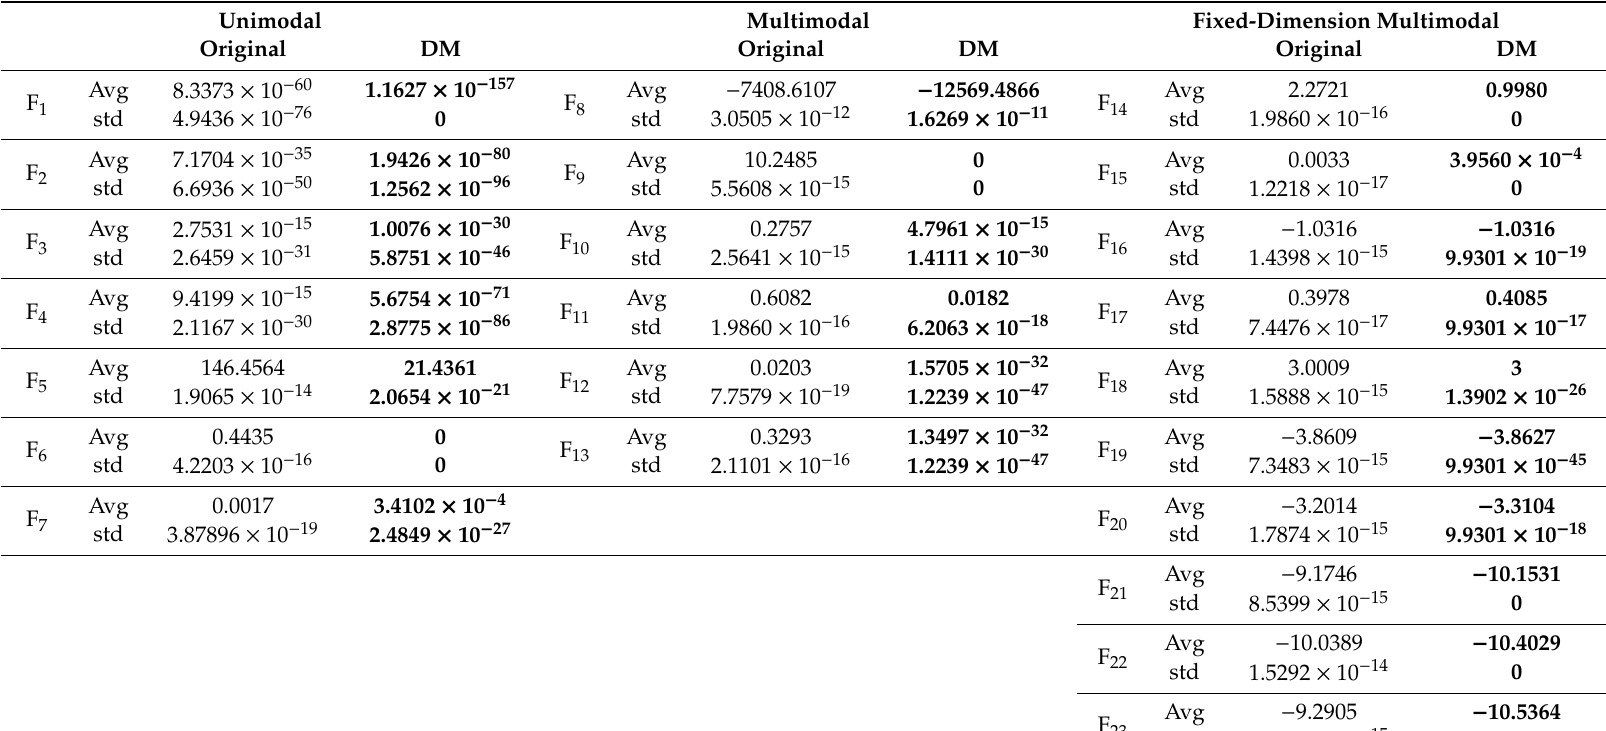
Table 5. Optimization results of teaching learning based optimization (TLBO) for original and “modified by DM”